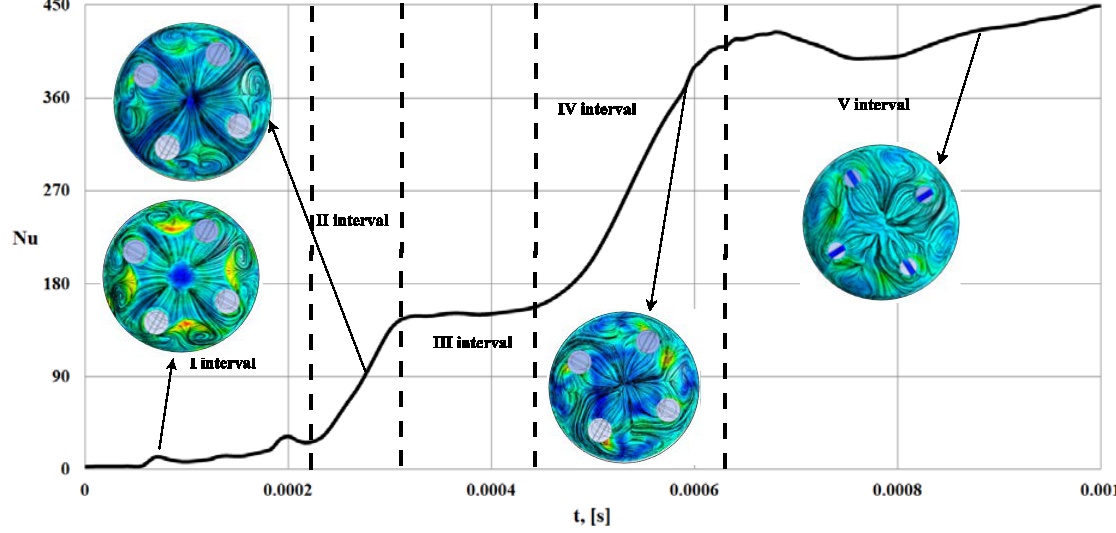
Figure 5. Obtained intervals of quasi-stationary topological modes with an account of changes in thermal conditions at the point of stagnation: black lines are flow lines, color counter is a field of heat transfer coefficient (minimal is a blue color, maximal is a red color).